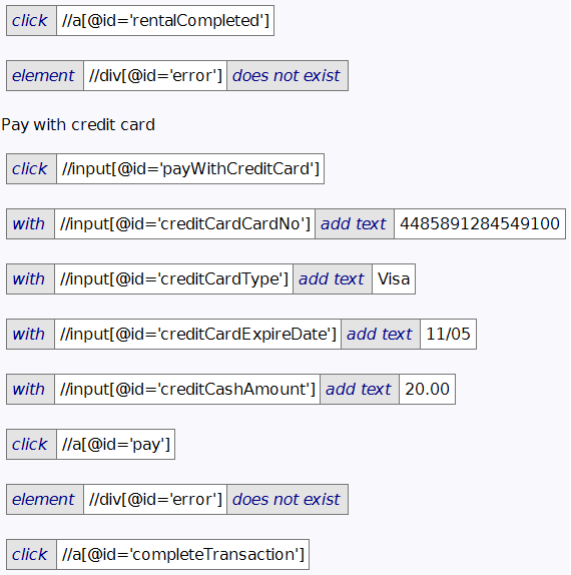
Figure 1. The middle segment of a longer